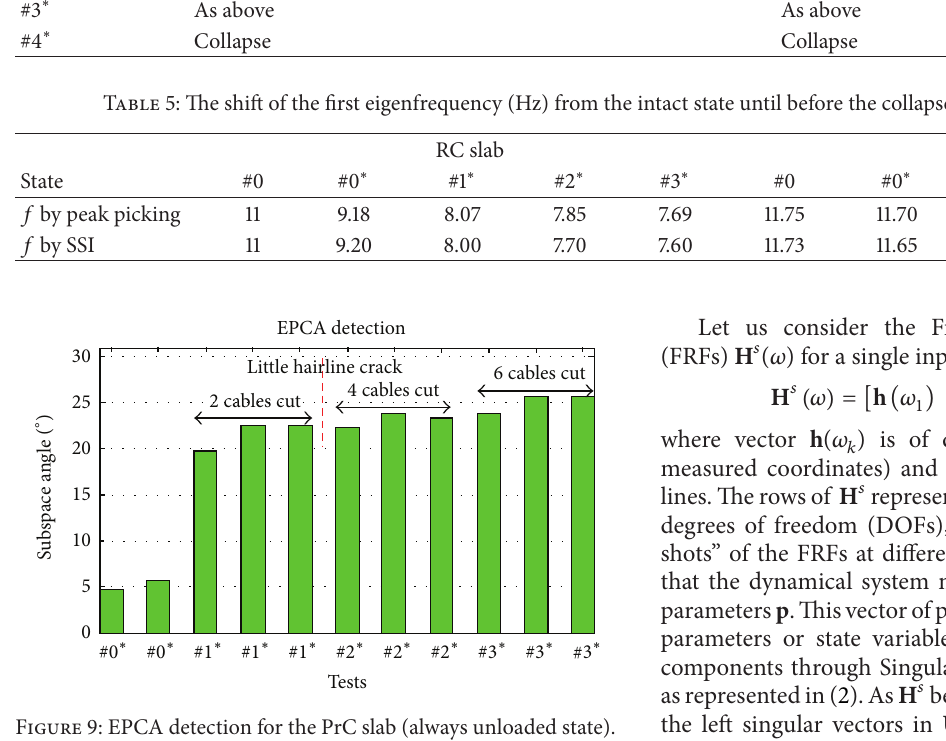
Figure 9: EPCA detection for the PrC slab (always unloaded